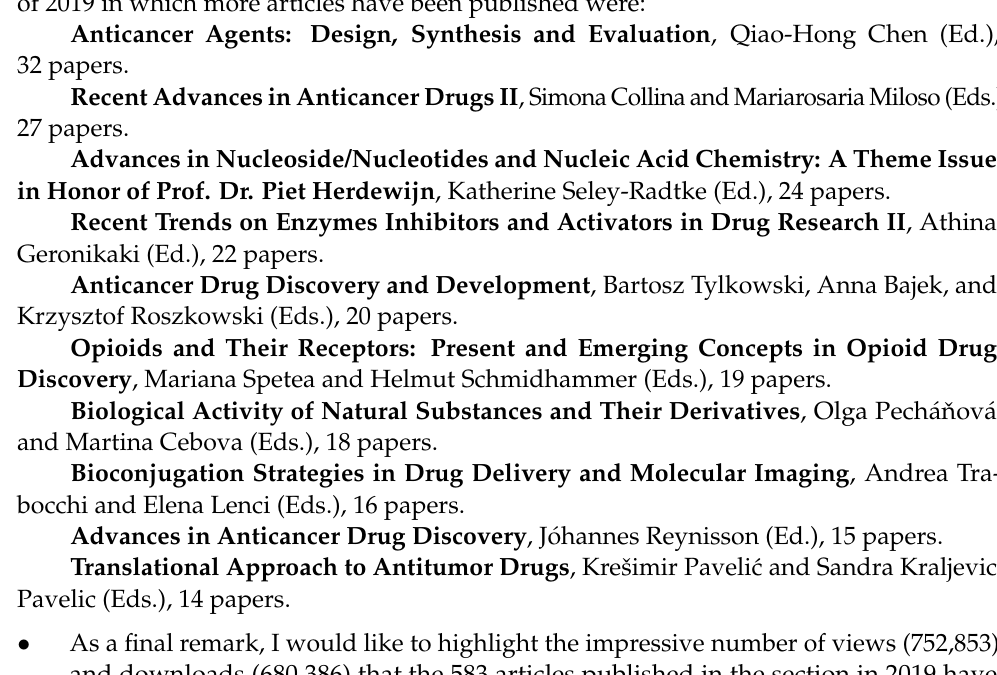
Figure 3. Total number of special issues launched in the Medicinal Chemistry section of Molecules in 2019.